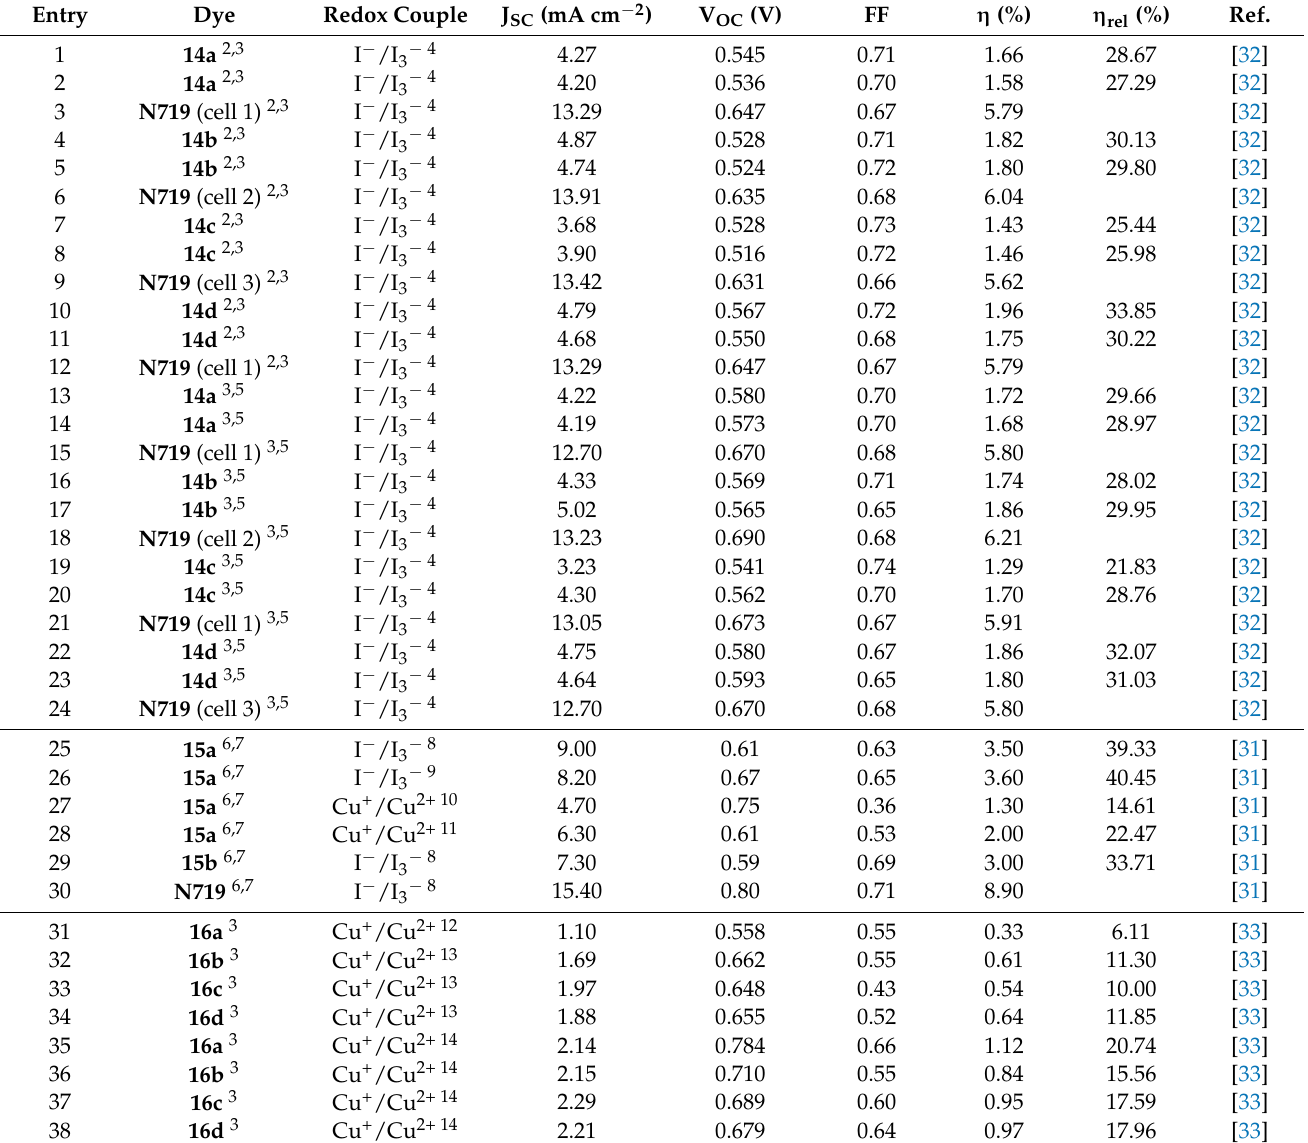
Figure 7. Structure of dyes 14a – d and 15a – b . Table 4. Photovoltaic data of DSSCs produced with dyes 14a – d , 15a – b , 16a – d , 17 , and 18a – d 1 .